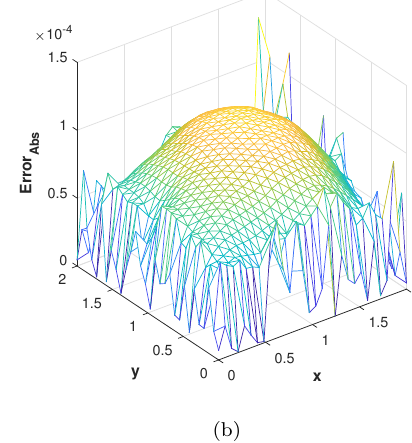
Figure 20: (a) Plot of Ab Error with = 900 , N S = 18 , σ n = 30 , α = 0 . 9 , z = 1 at T = 0 . 01. (b) Plot of Ab Error with = 900 , N S = 18 , σ n = 30 , α = 0 . 9 , z = 1 at T = 1.